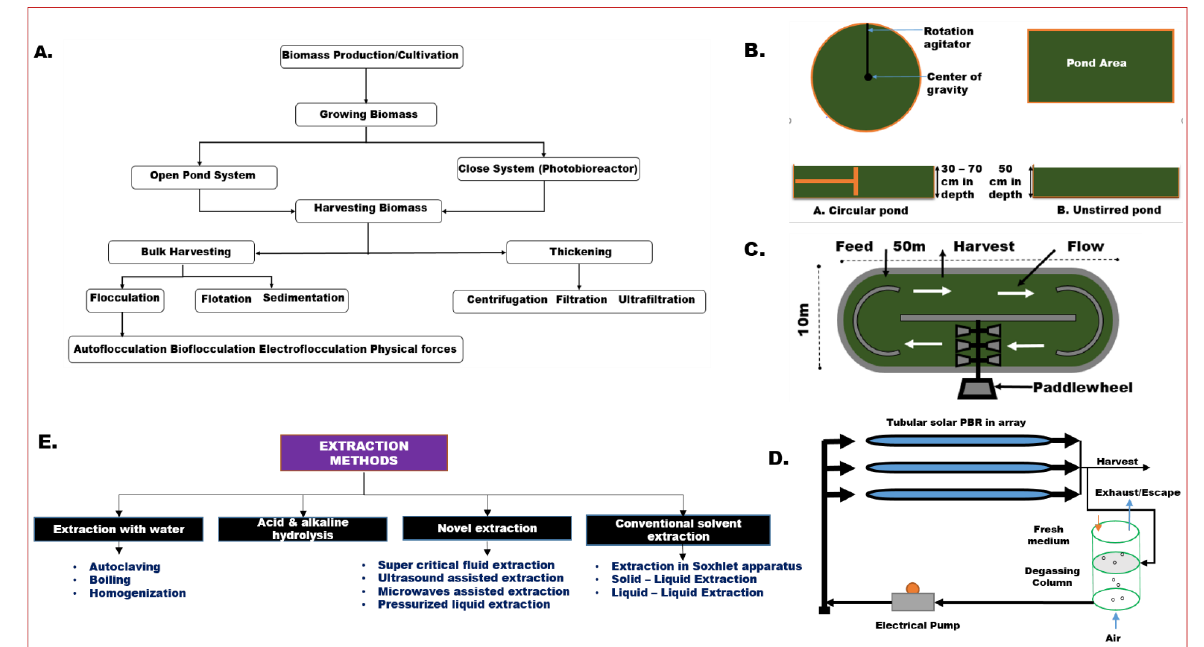
Figure 1. ( A ) Schematic of microalgae biomass production/cultivation; ( B ) types of open pond systems; ( C ) schematic raceway pond for microalgae cultivation; ( D ) schematic of solar-powered tubular PBR; ( E ) several techniques of production of microalgae